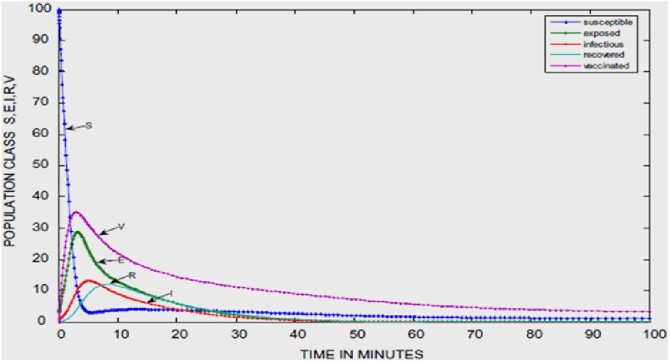
Time History of [12].